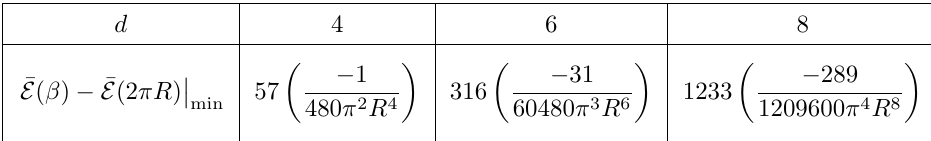
Table 2 . Lower bound on (cid:22) E ( (cid:12) ) (cid:0) (cid:22) E (2 (cid:25)R ) obtained from numerically evaluating the QEI (3.7) for the energy in eq. (3.2) and the weight functions in eqs. (3.8). The most constraining bound comes from taking ( ’ 1 ( t )) q with q d =4 = 2 : 57, q d =6 = 5 : 2 and q d =8 =